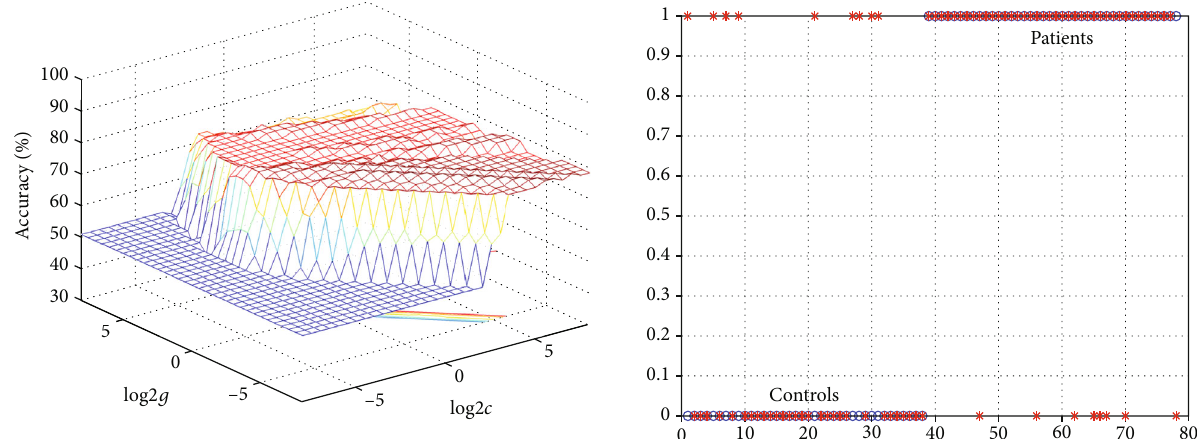
Figure 3: Visualization of SVM results by using FC values between the left NAc and the bilateral medial prefrontal cortex to di ff erentiate patients with OCD from HCs. Left: 3D visualization of SVM with the best parameters; right: classi fi cation map of the FC values of the bilateral middle cingulate cortex; SVM: support vector machine; FC: functional connectivity; NAc: nucleus accumbens; OCD: obsessive- compulsive disorder; HCs: healthy